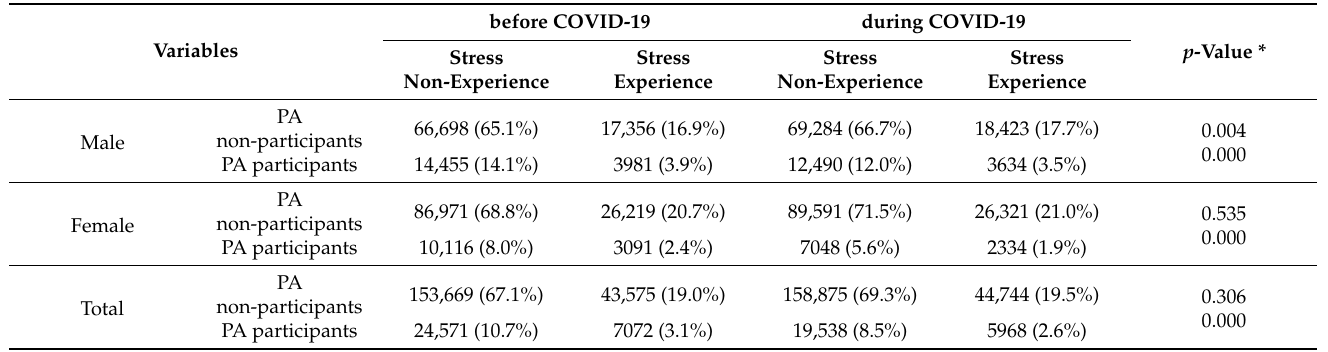
Table 2. Changes in stress by gender and regular PA before and during COVID-19.